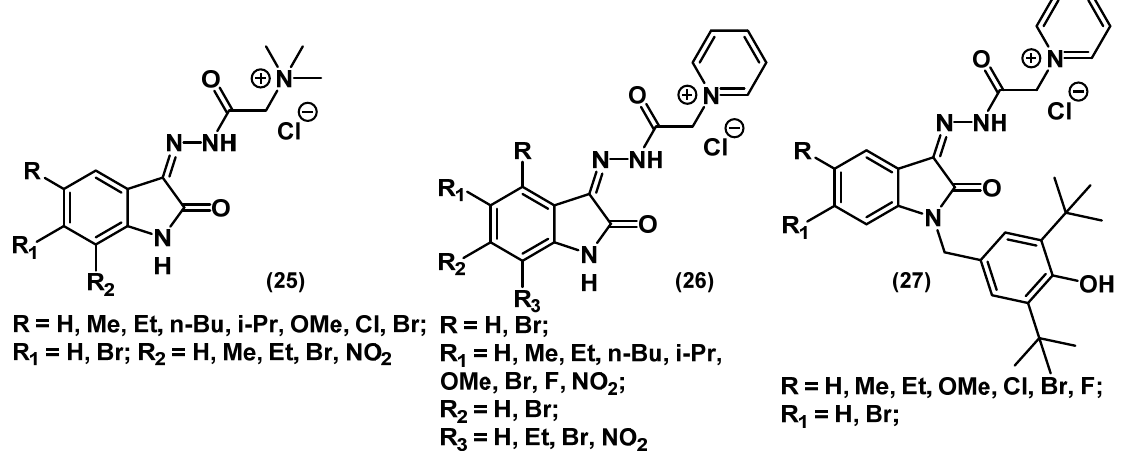
Figure 13. Isatin-based mono-QACs.